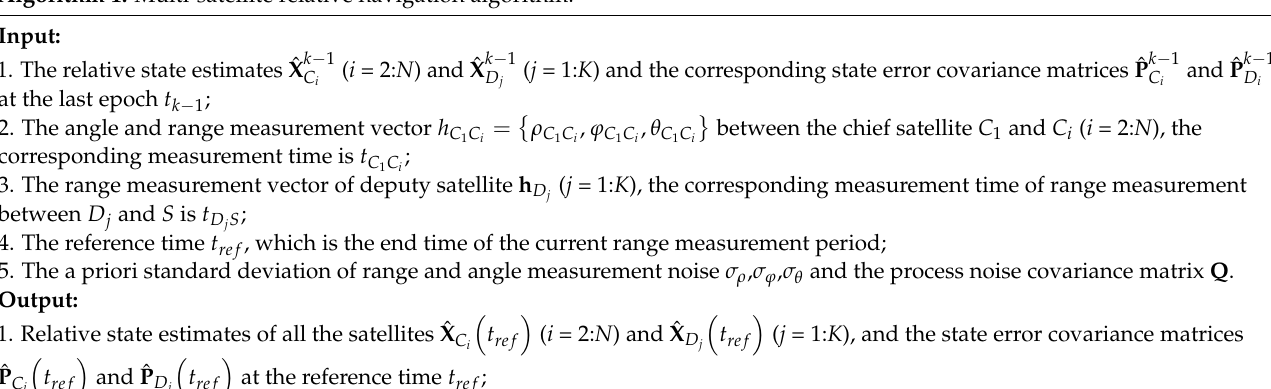
Algorithm 1. Multi-satellite relative navigation